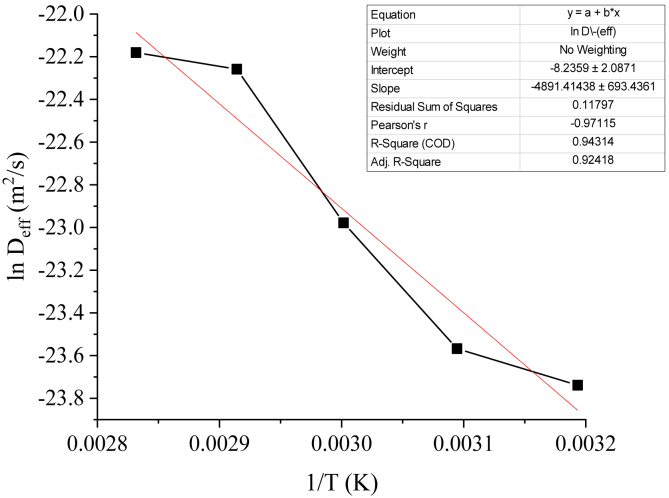
Plot of ln Deff vs 1/T.